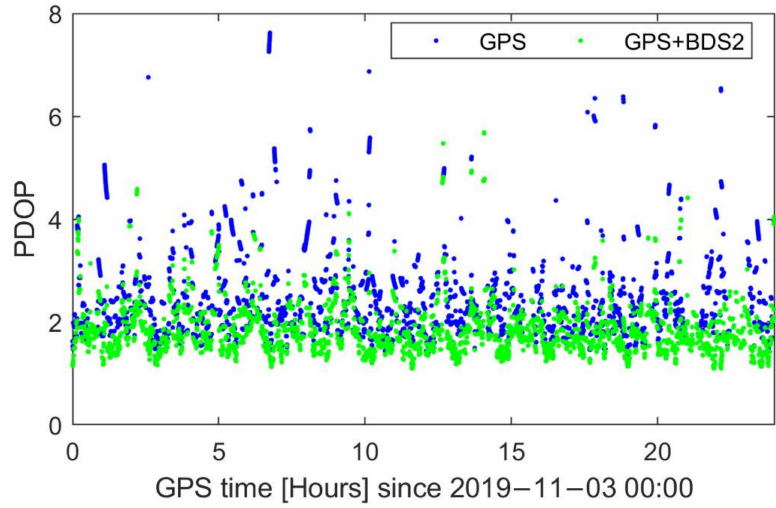
Figure 10. GPS-based and combined PDOP of TH-2A on DOY 307 in 2019.